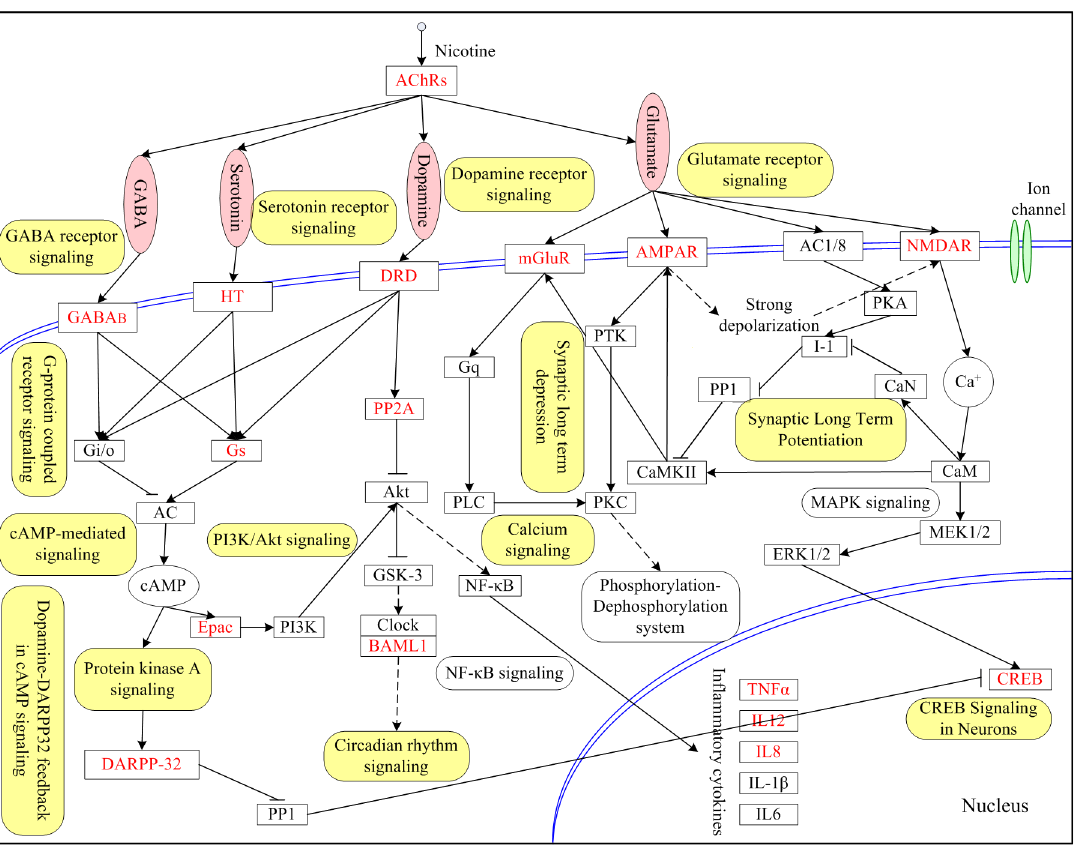
Fig 3. Molecular network for nicotine addiction. This network is constructed based on the nicotine addiction-related pathways or pathway crosstalk identified in our study, NA-specific network and literature survey. NAGenes are highlighted in red while neurotransmitters are represented as pink ellipse. The enriched pathways are highlighted in yellow